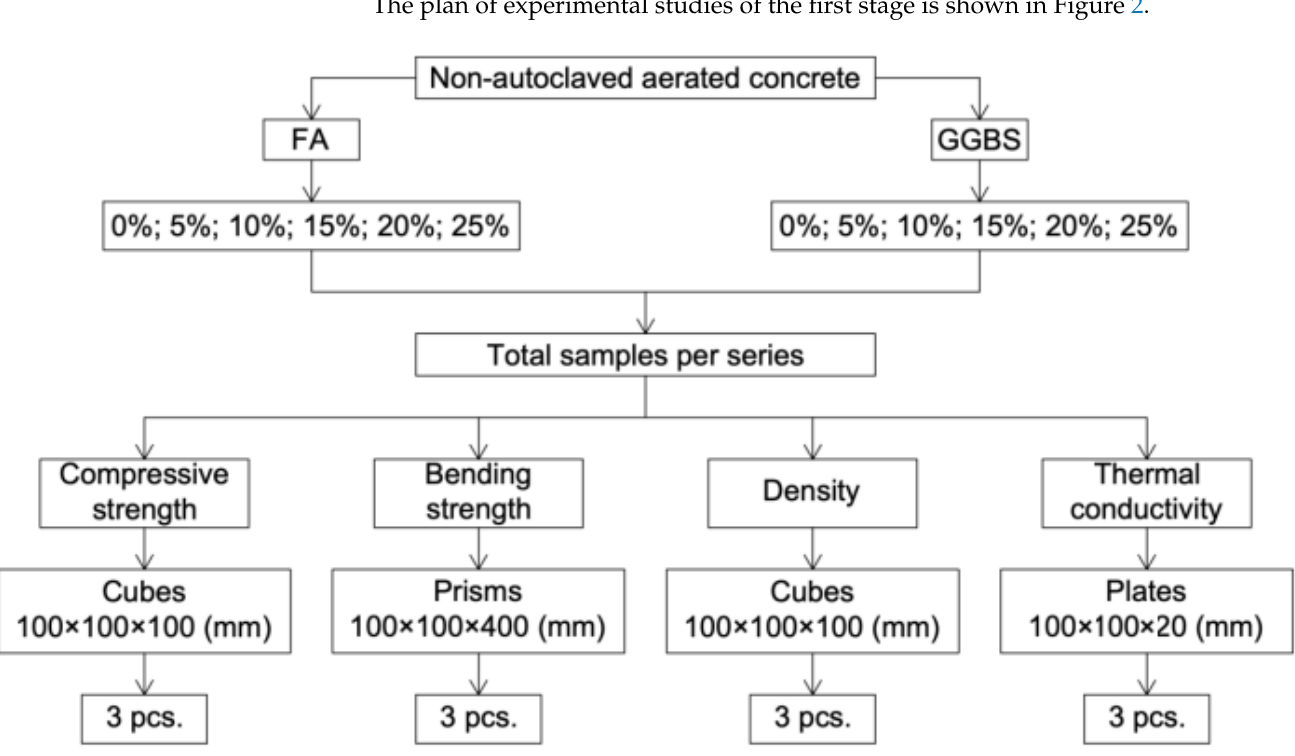
Figure 2. Plan of experimental studies of the first stage: determination of rational dosages of the modifier.